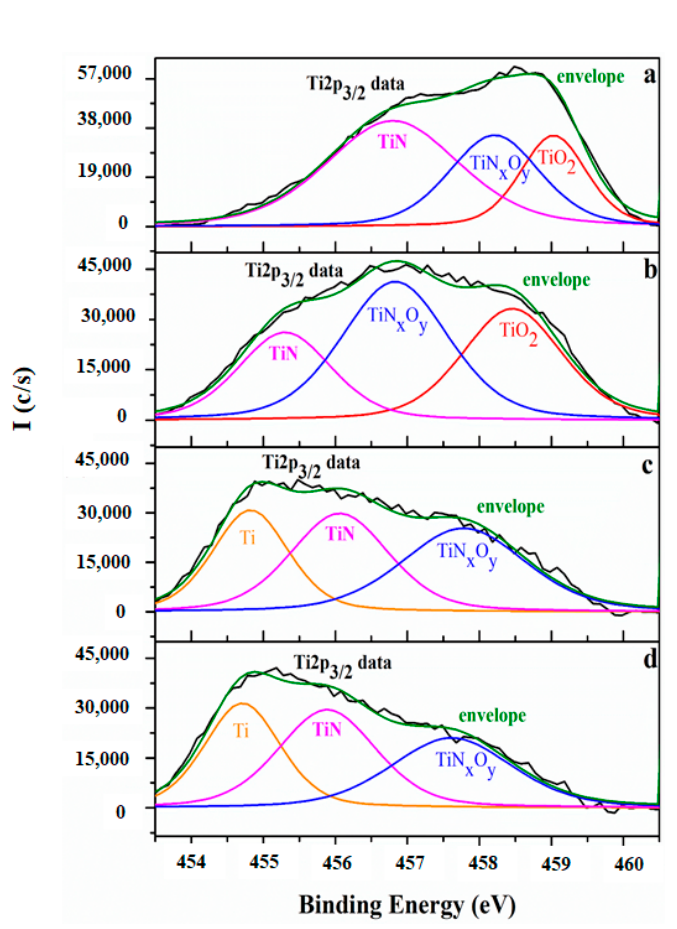
Figure 7. ( a – d ): Peak fitting of high resolution XPS spectrum of Ti2p 3/2 of S2 (annealed at 300 ° C) TiN film: ( a ) taken after 30 s etching; ( b ) taken after 90 s etching; ( c ) taken after 150 s etching; ( d ) taken after 210 s etching . Table 2. Peak positions of deconvoluted Ti2p 3/2 .